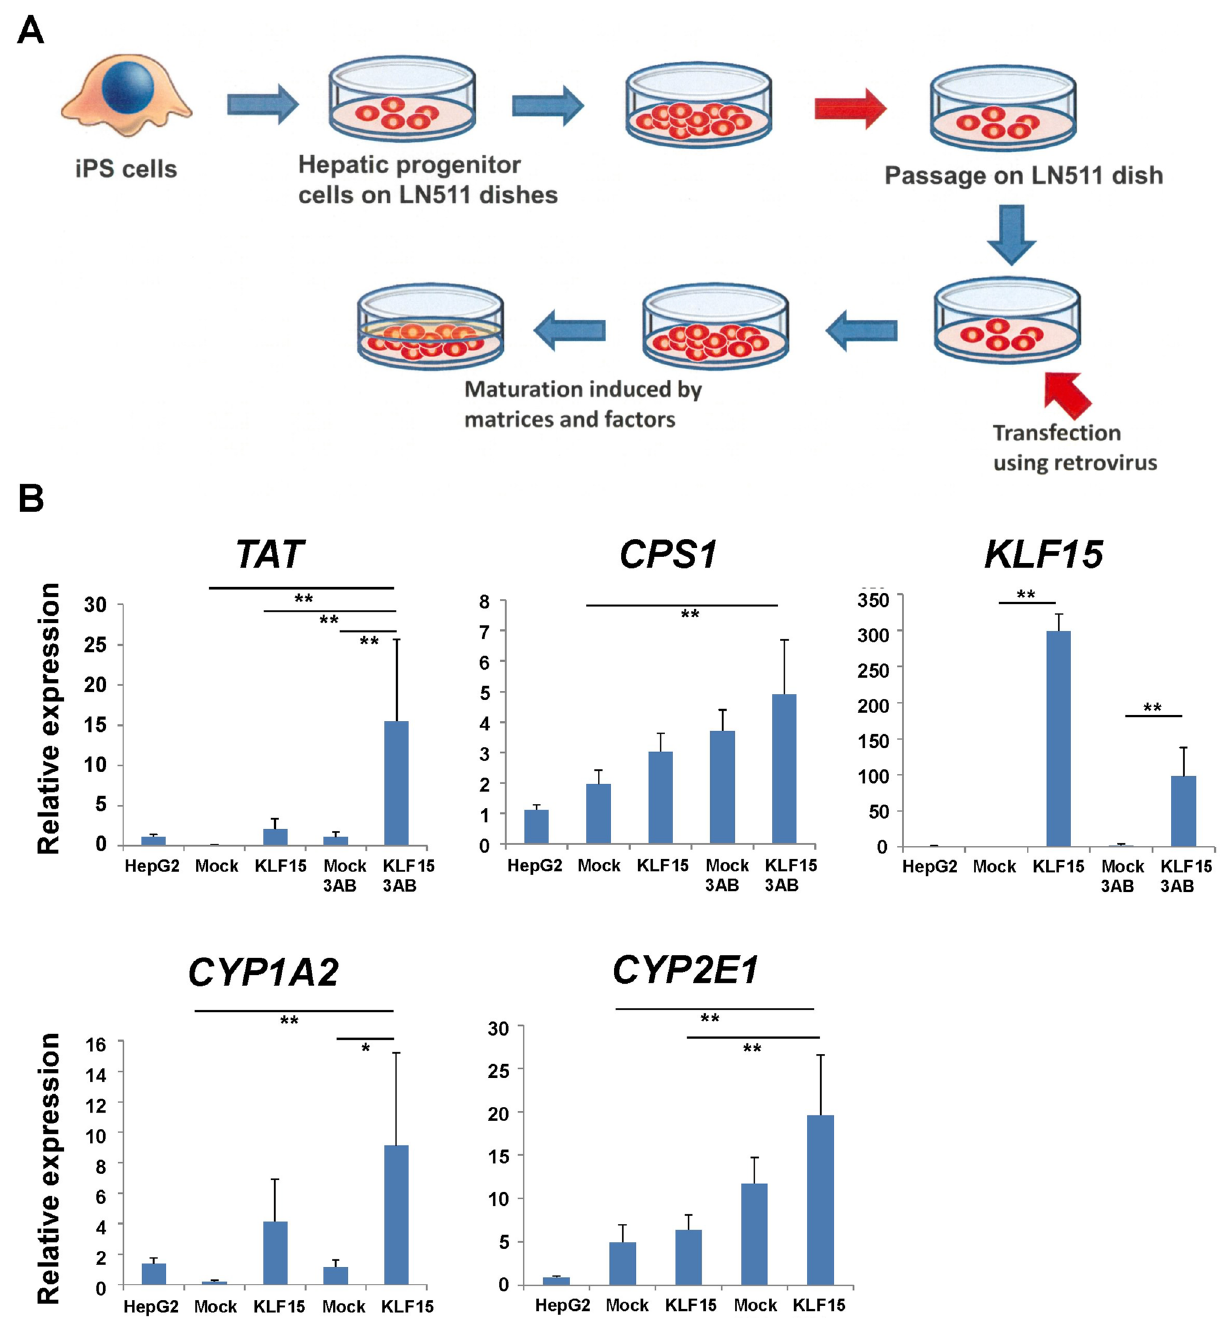
Figure 5. Induction of hepatic maturation by KLF15 in human iPSC-derived hepatoblasts. ( A ) The schema of the gene transduction system of hepatoblasts derived from human iPSCs. Human hepatoblasts derived from iPSCs were cultured on LN511-coated dishes and infected with retroviral vectors to induce gene expression. After infection, hepatic maturation was induced under suitable culture conditions. ( B ) Overexpression of KLF15 in human hepatoblasts. As shown in ( A ), after culturing, the expression of TAT , CPS1 , CYP1A2 , CYP2E1 , and KLF15 were analyzed using quantitative RT-PCR. Gene expression in cells infected with the mock vector was set to 1.0. Results are represented as the mean expression ± SD (n = 3). *P < 0.05, **P <